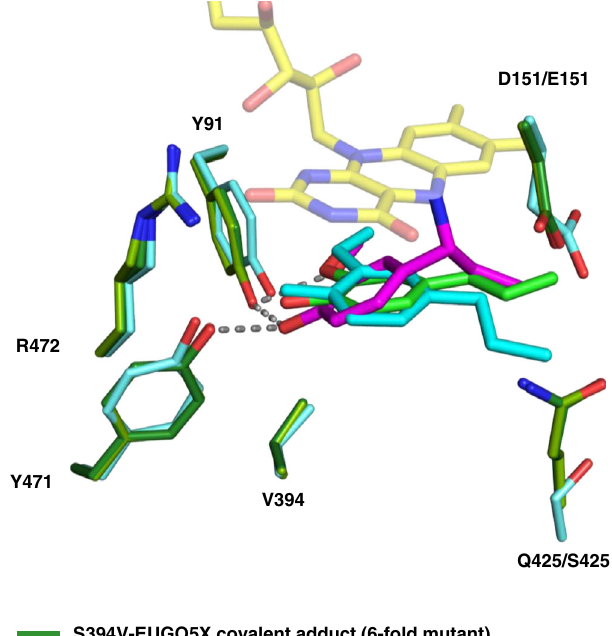
Fig. 7 | Structural comparison between S394V-EUGO5X (covalent and non- covalent) and PROGO. The interactionswith Y91 and Y471 are shownwith dashed lines. They are involved in deprotonating 4- n -propylguaiacol (Fig. 1). The covalent and non-covalent substrates found in the structure of the S394V-EUGO5X mutant are shown in magenta and green, respectively. The substrate bound to the D151E/ S394V/Q425S-EUGO5X mutant (PROGO) is shown in cyan. The side chains of the S394V-EUGO5X mutant are represented in green, with a darker green used for the subunit bearing the covalent adduct. The side chains of D151E/S394V/Q425S- EUGO5X are represented in light